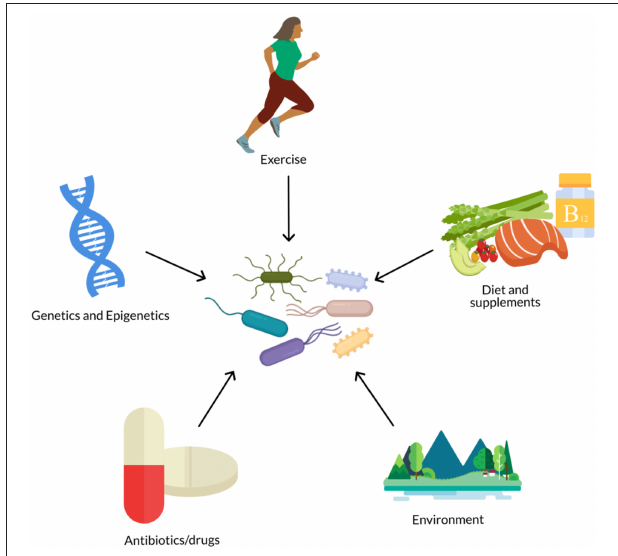
FIGURE 1 | The gut microbiome is influenced by numerous biological and lifestyle factors such as diet, genetics, antibiotics, exercise, and environment (e.g., pollutants, urban vs. rural,